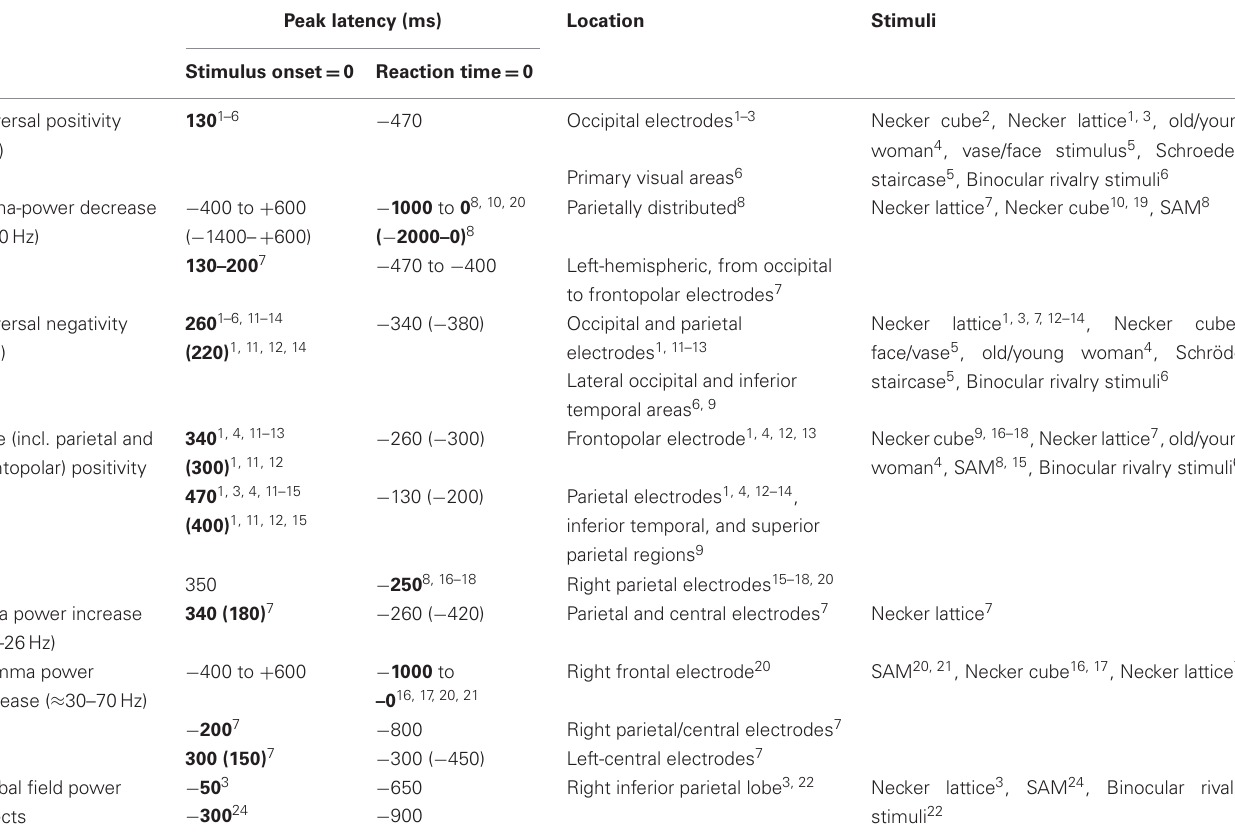
Table 1 | EEG correlates of endogenous and exogenously induced (parentheses) perceptual reversals and their temporal occurrences with reference to stimulus onset (onset paradigm) or to reaction times (manual response